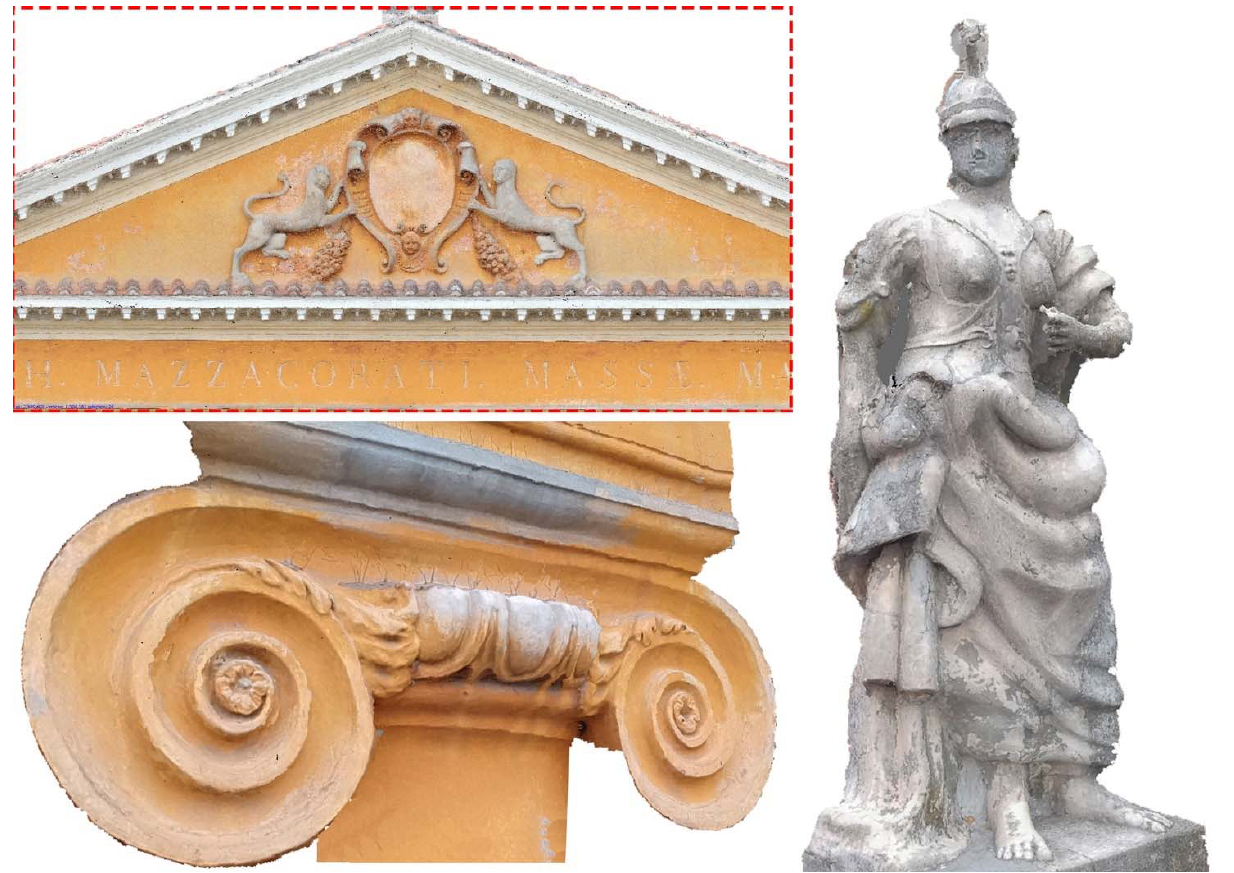
Figure 9. 3D image-based models of tympanum decoration, capital and the central-upper statue over the